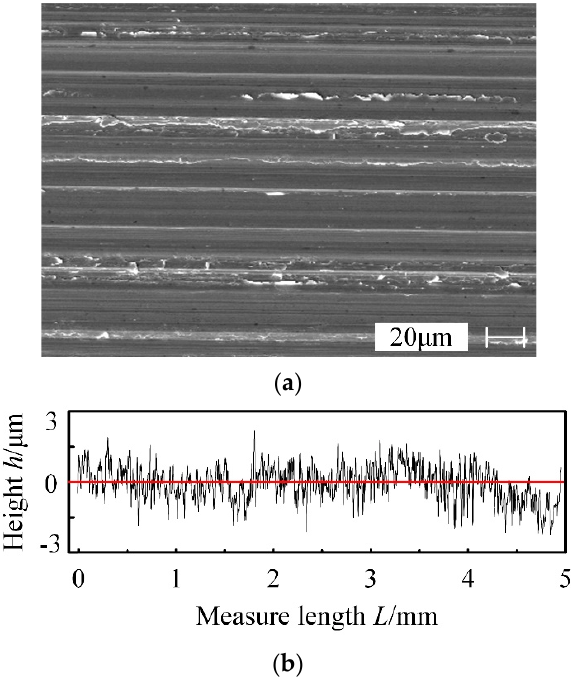
Figure 12. Machined surface by the 600# CBN wheel with wear failure. ( a ) Surface morphology machined by CBN wheel with failure wear, ( b ) Profile at the wear failure stage.